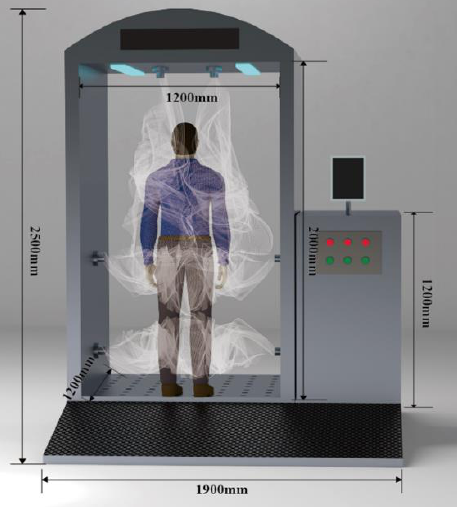
Figure 3. The disinfection door based on the atomized PATW (Spray volume of PATW: 10 L/h).